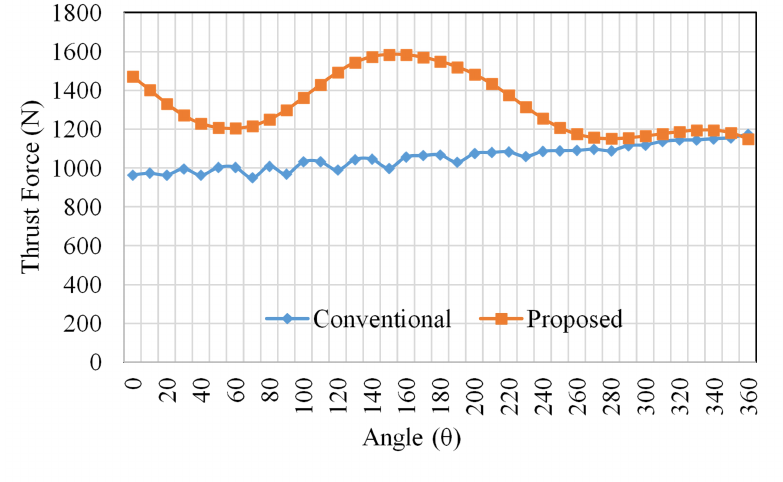
Figure 11. Comparison of thrust force for the conventional and proposed machine for ropeless elevator application.